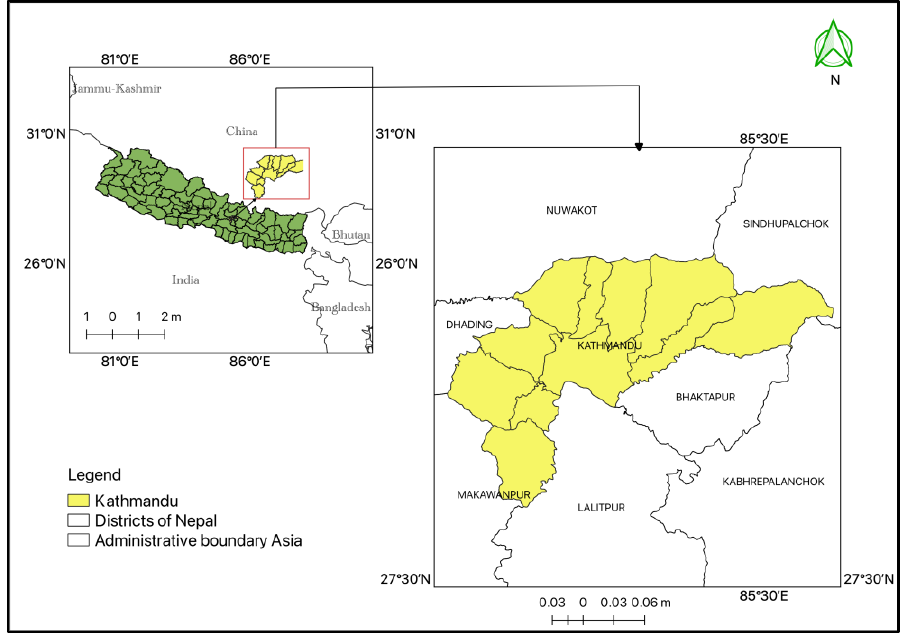
Figure 1. Map showing study area (Kathmandu district). Kathmandu faces the enduring challenge of weakly regulated, often unplanned, and poorly managed development. The total population of the district is 2,017,532, with a density of 5108 per km 2 [42]. The population is growing at the rate of 1.4% per year [42]; however, rural-urban migration adds to population pressures in the